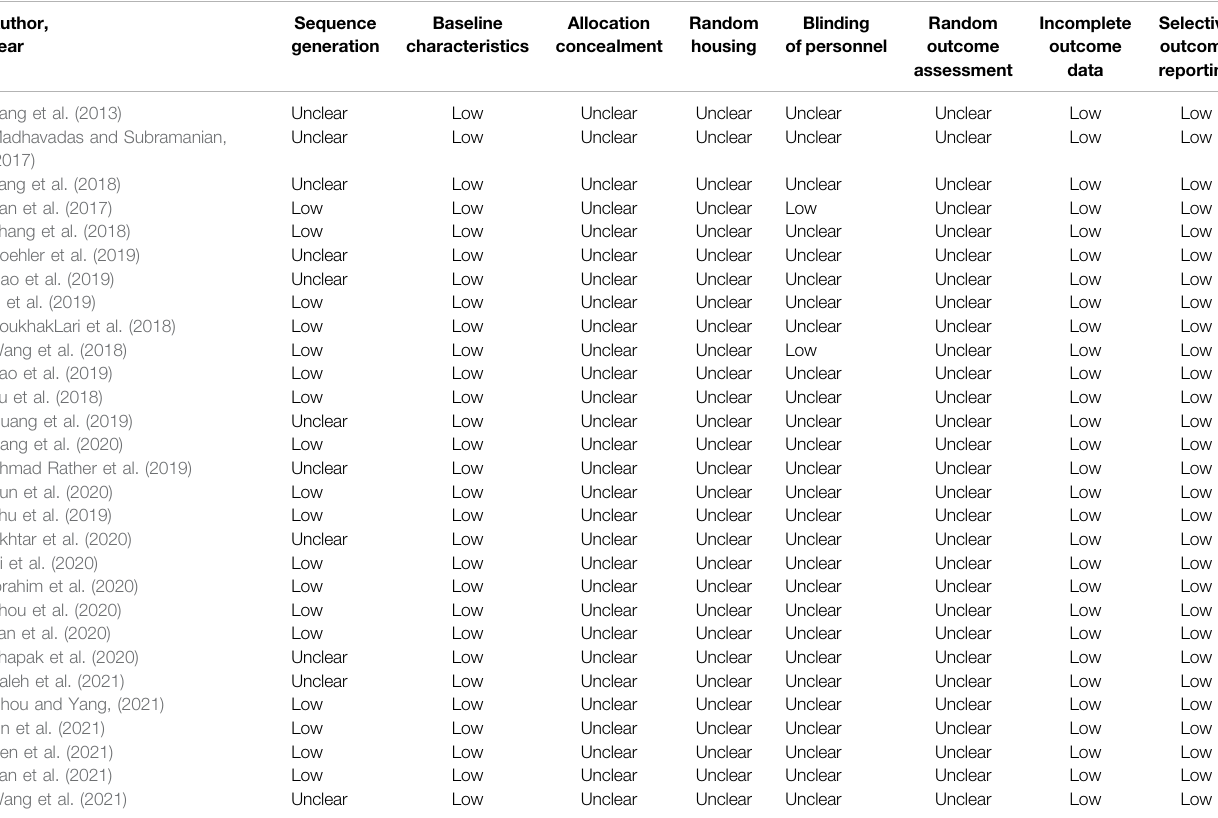
TABLE 2 | SYRCLE risk of bias for animal